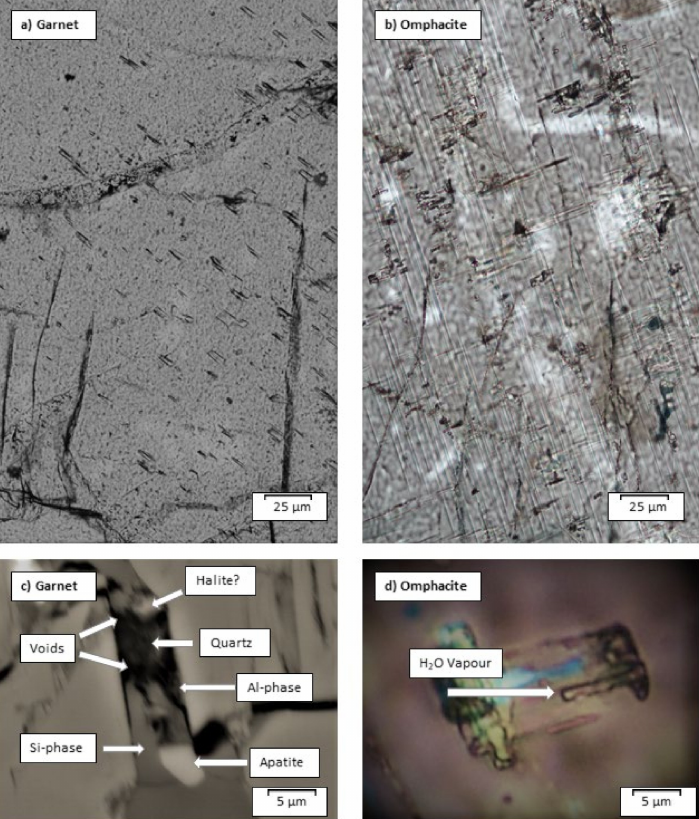
Figure 3. Photomicrographs of ( a ) garnet- and ( b ) omphacite-hosted inclusions, sample QC26E quartz eclogite, Årsheimneset. ( c ) Back-scattered electron image of a multi-phase inclusion in garnet in sample Q26G, opx eclogite, Årsheimneset, showing voids and solid phases (apatite, quartz, halite? and Al and Si phases). ( d ) Photomicrograph of omphacite-hosted fluid inclusion showing trapped H 2 O vapour in sample